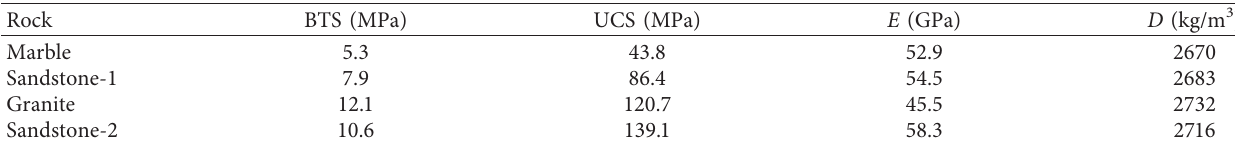
Table 2: The mechanical properties of